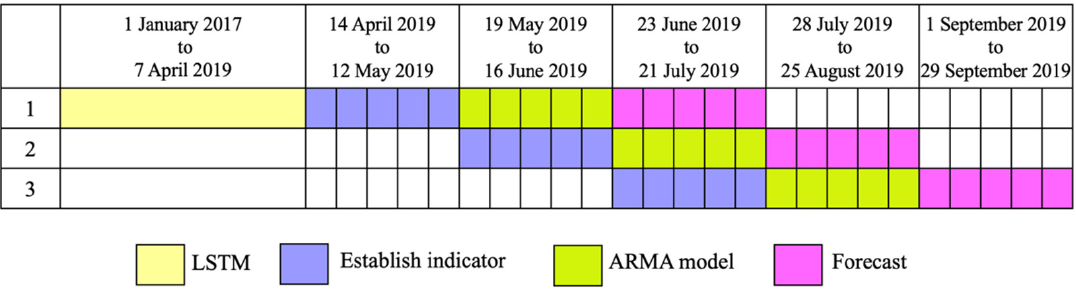
Figure 5. The rolling prediction process.